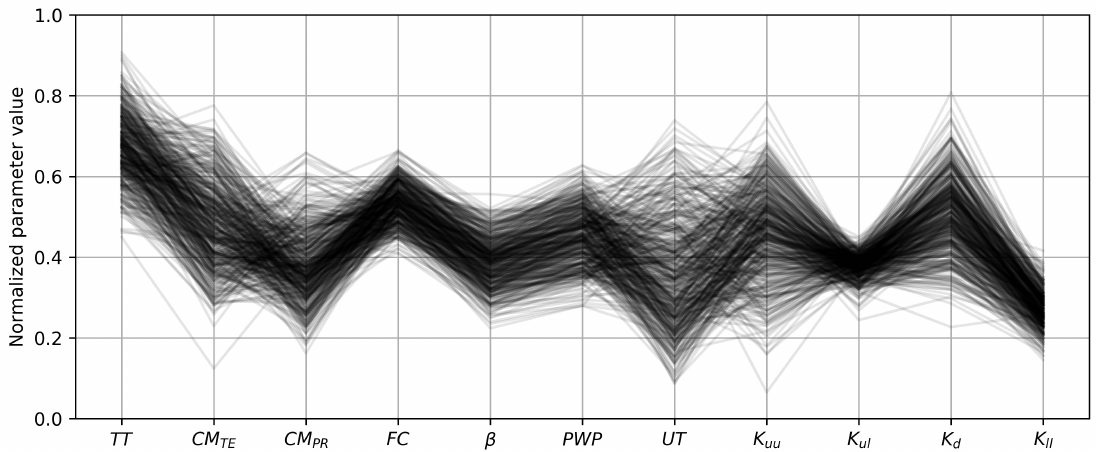
Figure 2. Well performing model parameters (N = 441) for the present day calibration period using ROPE.